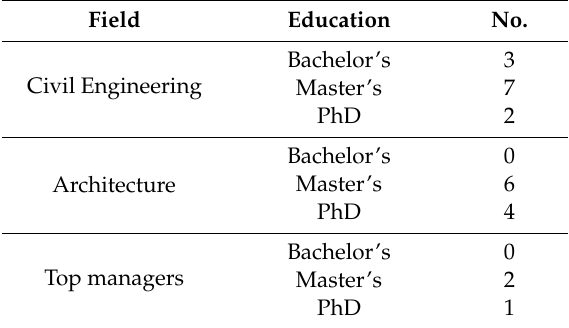
Table 1. Background information of